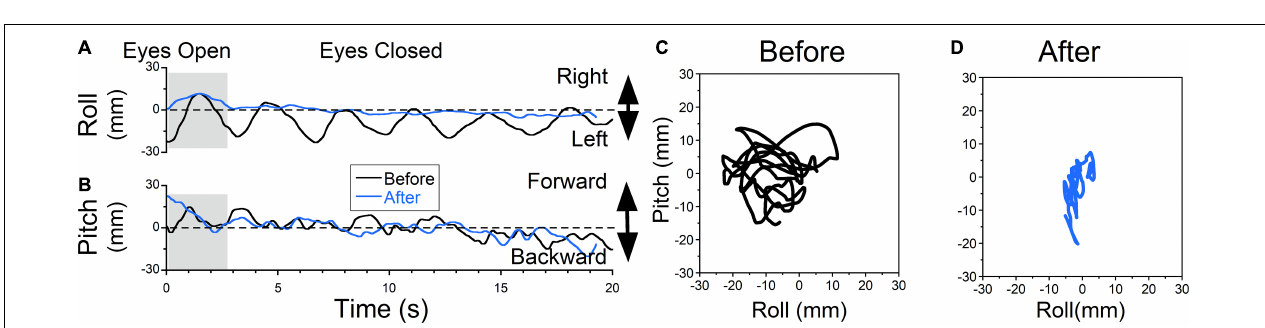
FIGURE 6 | The COP changes as a function of time (Static posturography). (A) Side-to-side (swaying) body oscillations. (B) Forward-back (rocking) body oscillations. Static posturography of a 52-year-old female with MdDS triggered immediately after a flight. Prior to treatment, the patient had no swaying ( A , black trace) but reported strong backward gravitational pulling ( B , black trace). The shaded areas in (A,B) are intervals when the patient had her eyes open. (C,D) Trajectory plots of COP before (C) and after (D) exposure of upward OKS at 5 ◦ /s for 1 min. After treatment, postural stability increased ( A,B,D blue traces).